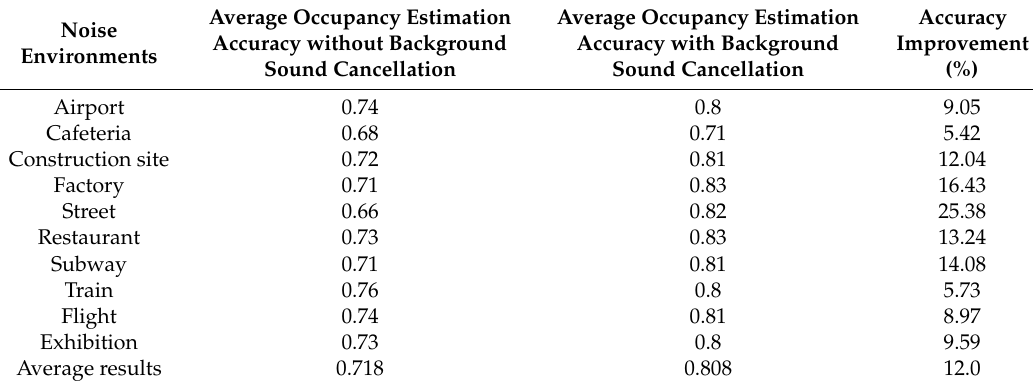
Table 3. Comparison of occupancy estimation accuracy before and after applying background sound cancellation algorithm, assuming 55 dB background sound and 60 dB human